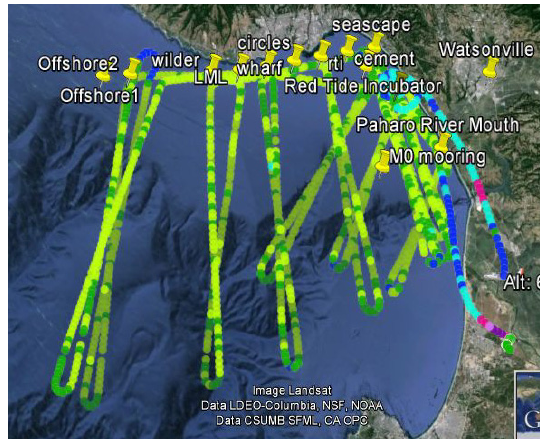
Figure 3. OCEANIA flight lines acquired 11-5-2013 to map water leaving radiance in coastal waters.